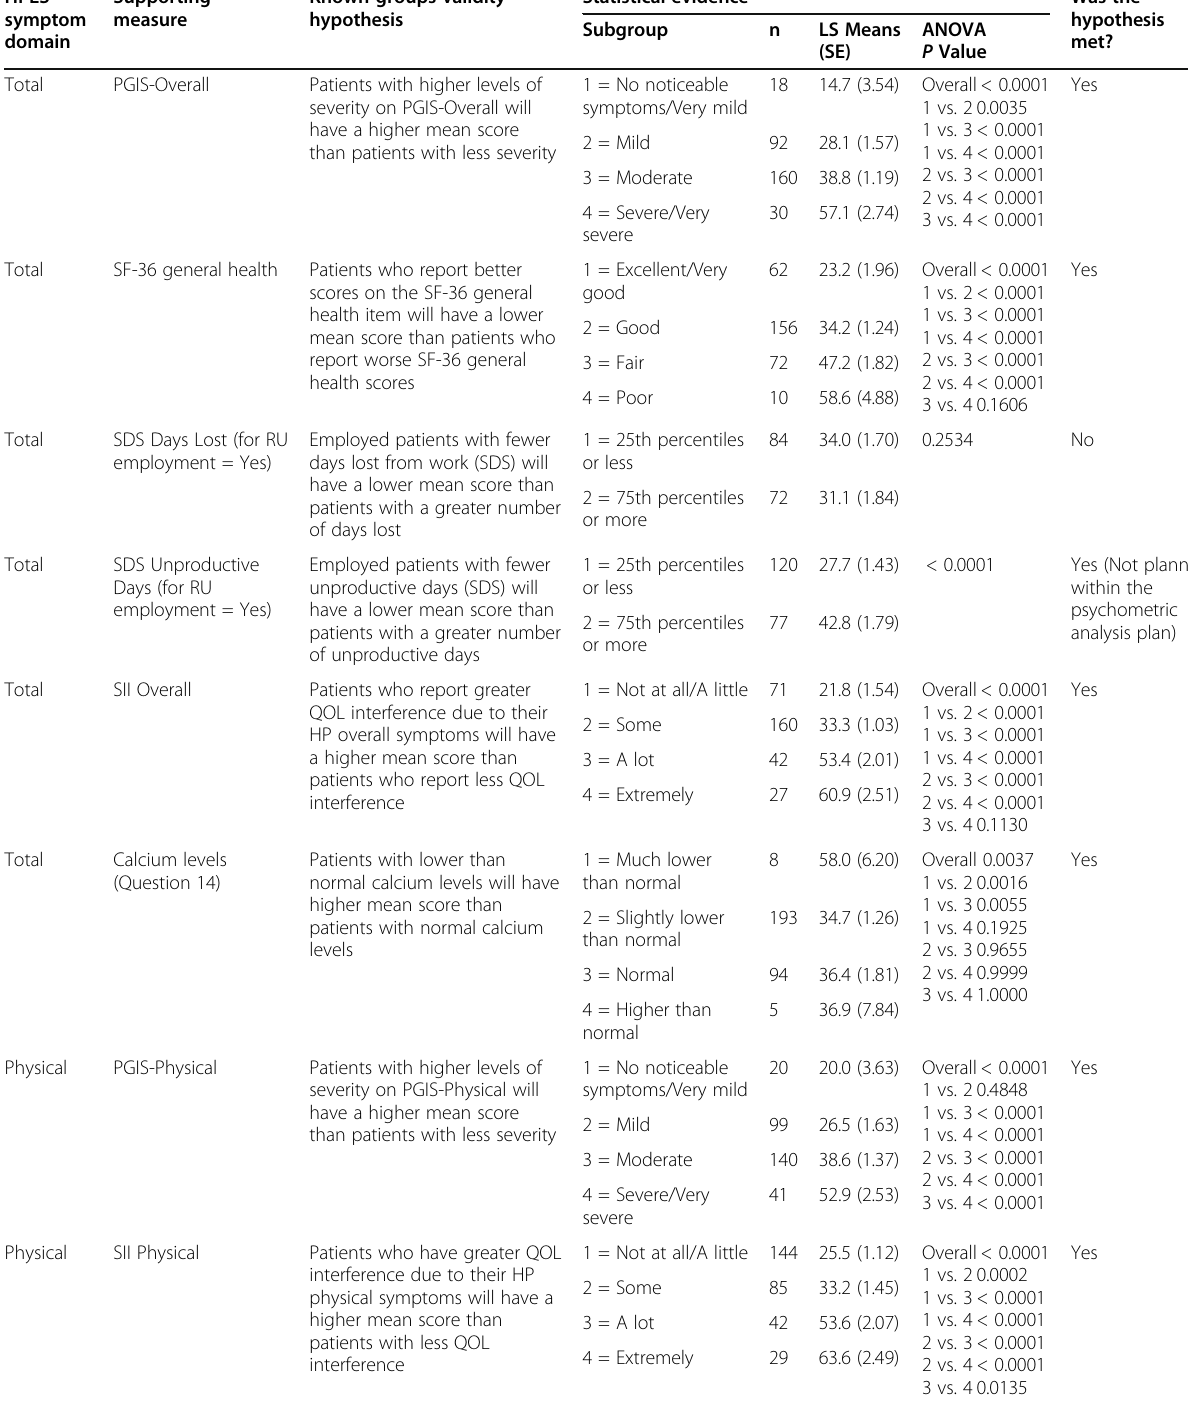
Table 4 Observational study known-groups validity hypotheses for HPES-Symptom HPES-